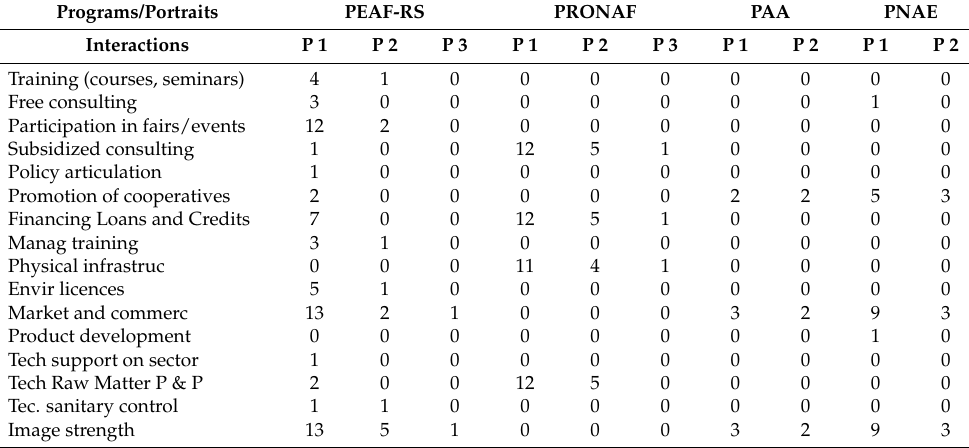
Table 3. Participation of family agribusiness (by portrait = P) in the different State programs as beneficiaries of different